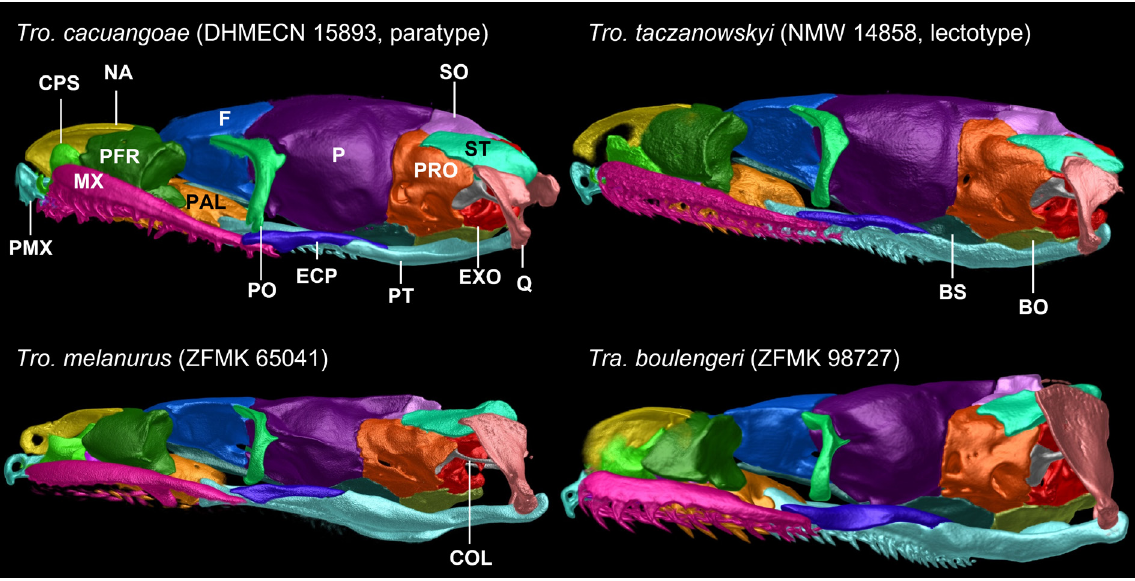
Fig. 11. Micro-CT images of the lateral view of the skulls of Tropidophis cacuangoae sp. nov., ♀ (DHMECN 15893, paratype), T. taczanowskyi (Steindachner, 1880) (NMW 14858, lectotype), T. melanurus